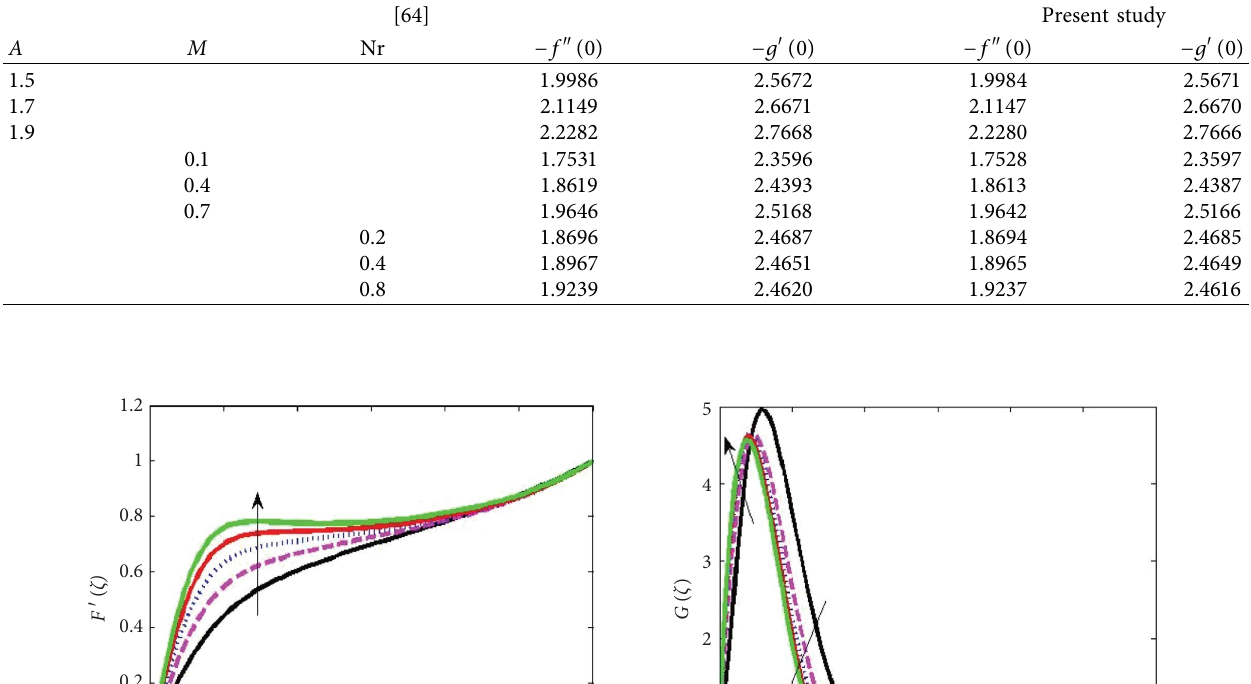
Table 4: Comparison of the present study with that of Abdelmalek et al. [64] when β �